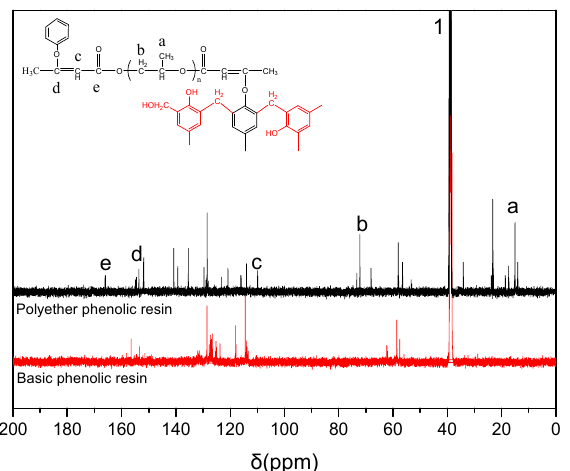
Figure 3. The 13 C NMR spectra of the basic phenolic resin and polyether phenolic resin (the amount of acetoacetic ester-terminated polyether is 16% of the amount of phenol).